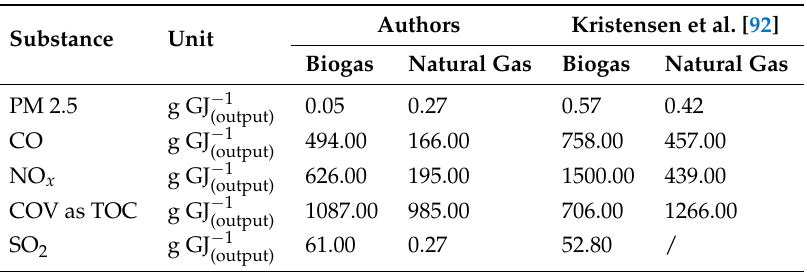
Table 16. Average regulated emissions in the present work and in Kristensen et al. [92]. The emissions refer to the electrical energy